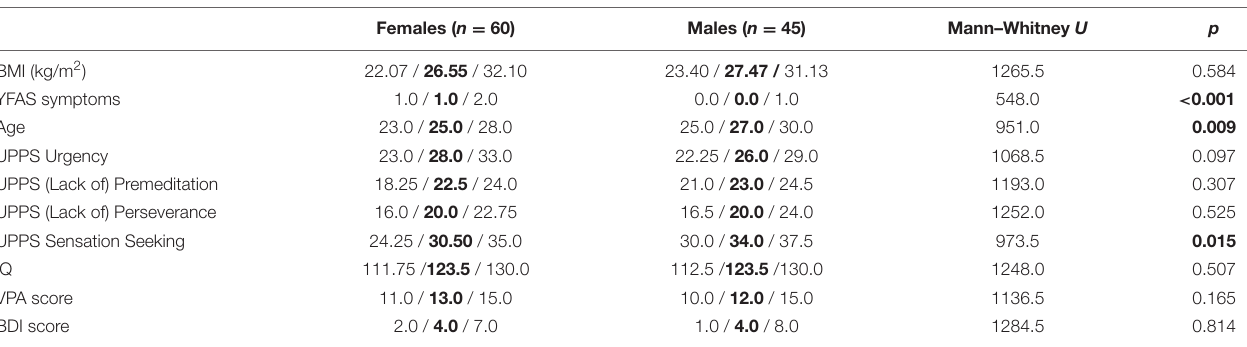
TABLE 2 | Descriptive statistics of the sample by